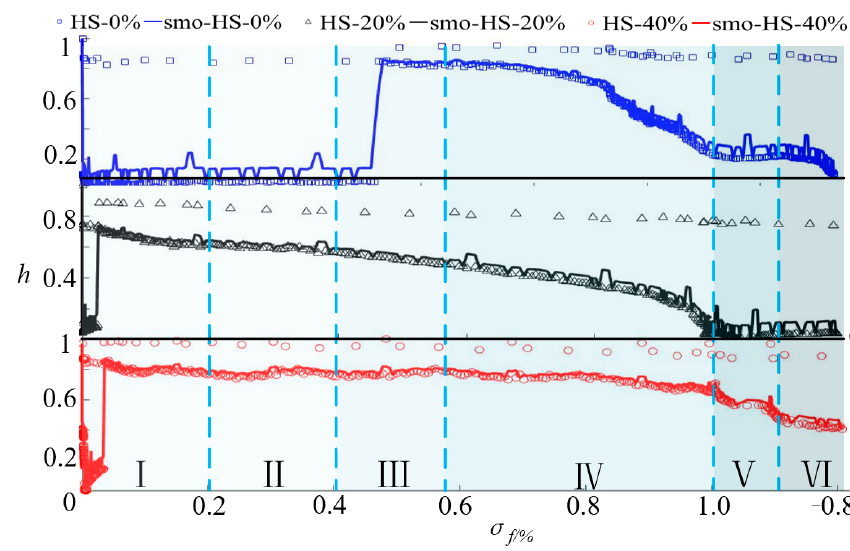
Figure 7. Grayscale entropy value–stress level curve.